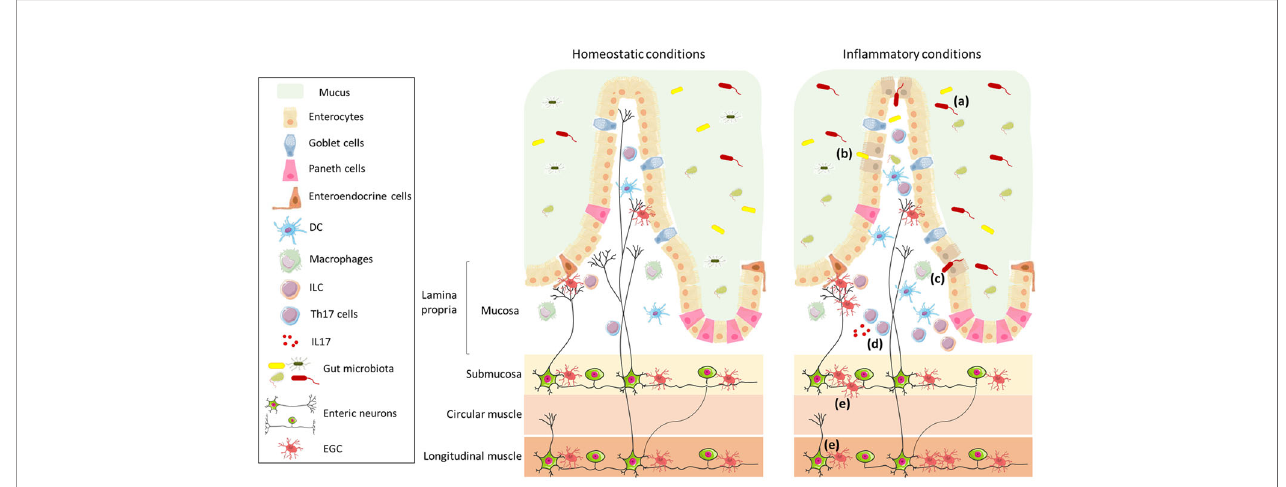
FIGURE 1 | Schematic representation of the intestinal wall in homeostatic and in fl ammatory conditions. The intestinal barrier is composed of mucus, which acts as physical and biochemical barrier, of a continuous monolayer of intestinal epithelial cells (including enterocytes, goblet cells, Paneth cells, and enteroendocrine cells), and of the lamina propria, which is densely populated by immune cells (such as DC, macrophages, ILC, and T cells). The intestinal barrier is directly exposed to the gut microbiota that has an important role in the maintenance of barrier integrity and in the regulation of the immune system. The lamina propria is innervated by enteric nerve fi bres, which originate in the myenteric and submucosal plexi and are in contact with EGC. The left panel shows the intestinal wall under homeostatic conditions; in the right panel, under in fl ammatory conditions, the composition of the gut microbiota is altered (a) , the intestinal epithelial barrier is impaired (b) , enabling translocation of microbes (or their products) (c) , and resulting in an increase in Th17 cells (d) and enteric axonal loss and gliosis (e)